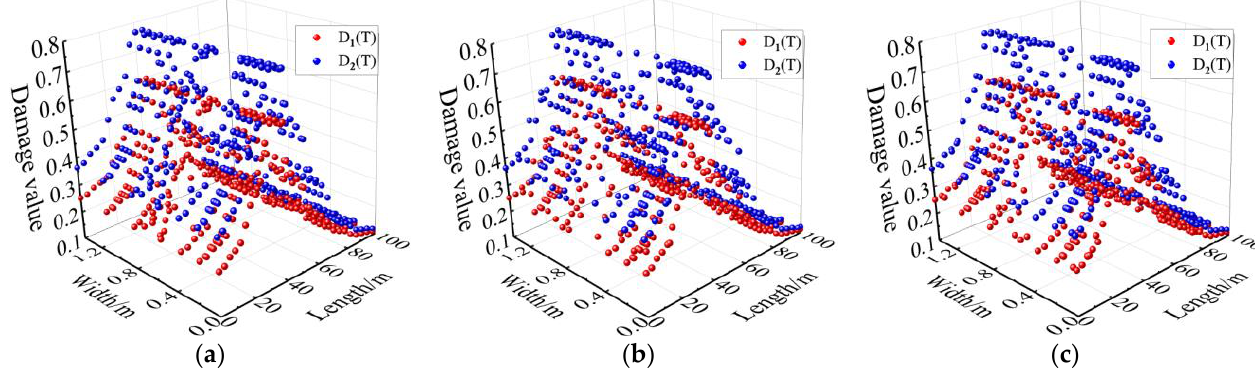
Figure 16. Damage value at different positions in the track bed: ( a ) surface; ( b ) middle; ( c ) bottom.